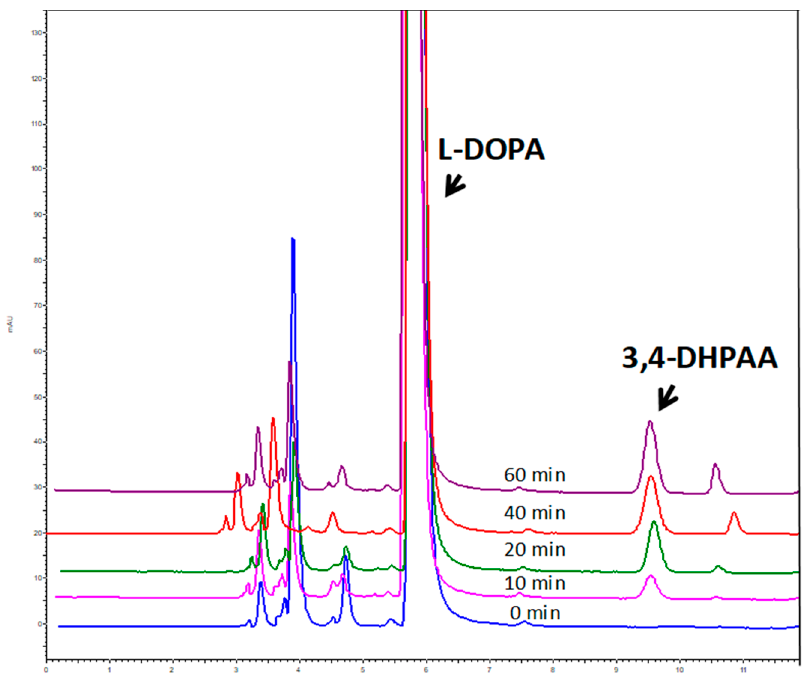
Figure 3. Time course of the formation of 2,4-DHPAA after incubation of recombinant OeAAS with L -DOPA. AAS activity was assayed as indicated in Material and Methods at different incubation times.